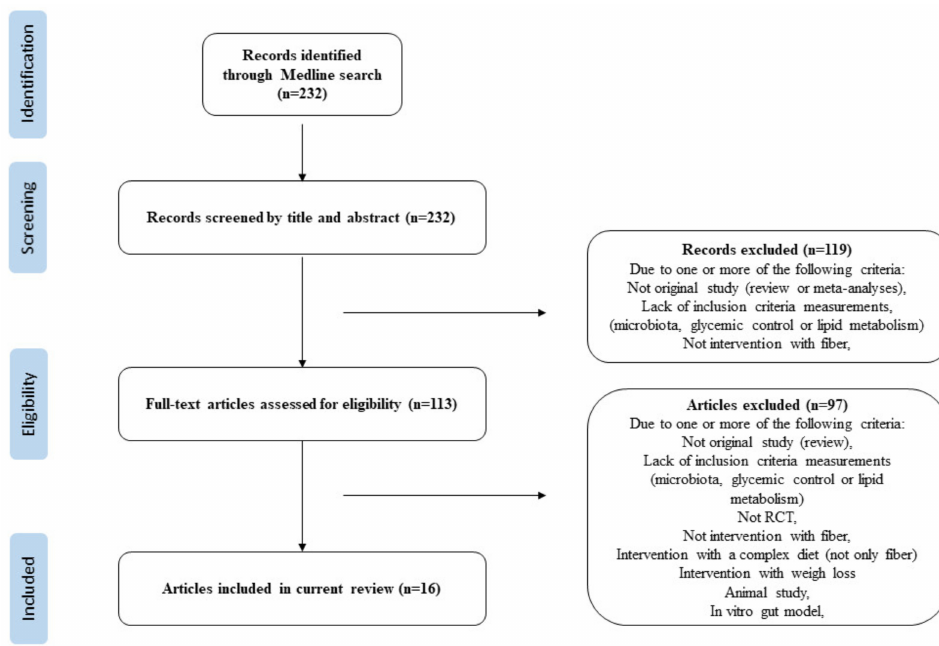
Figure 2. Flow chart showing the steps in the study